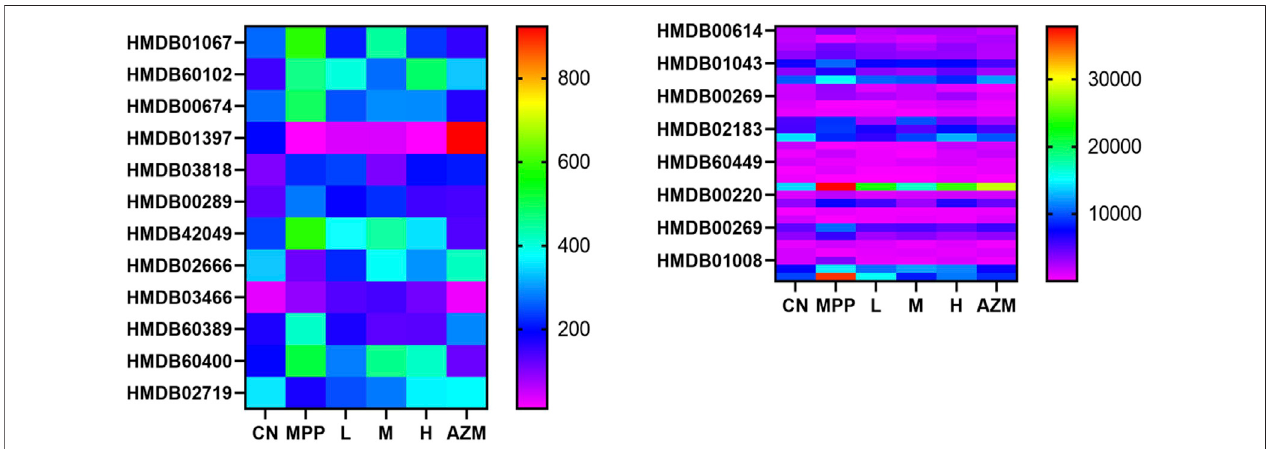
FIGURE 5 | Urine, serum, and lung tissue have a tendency to recall the